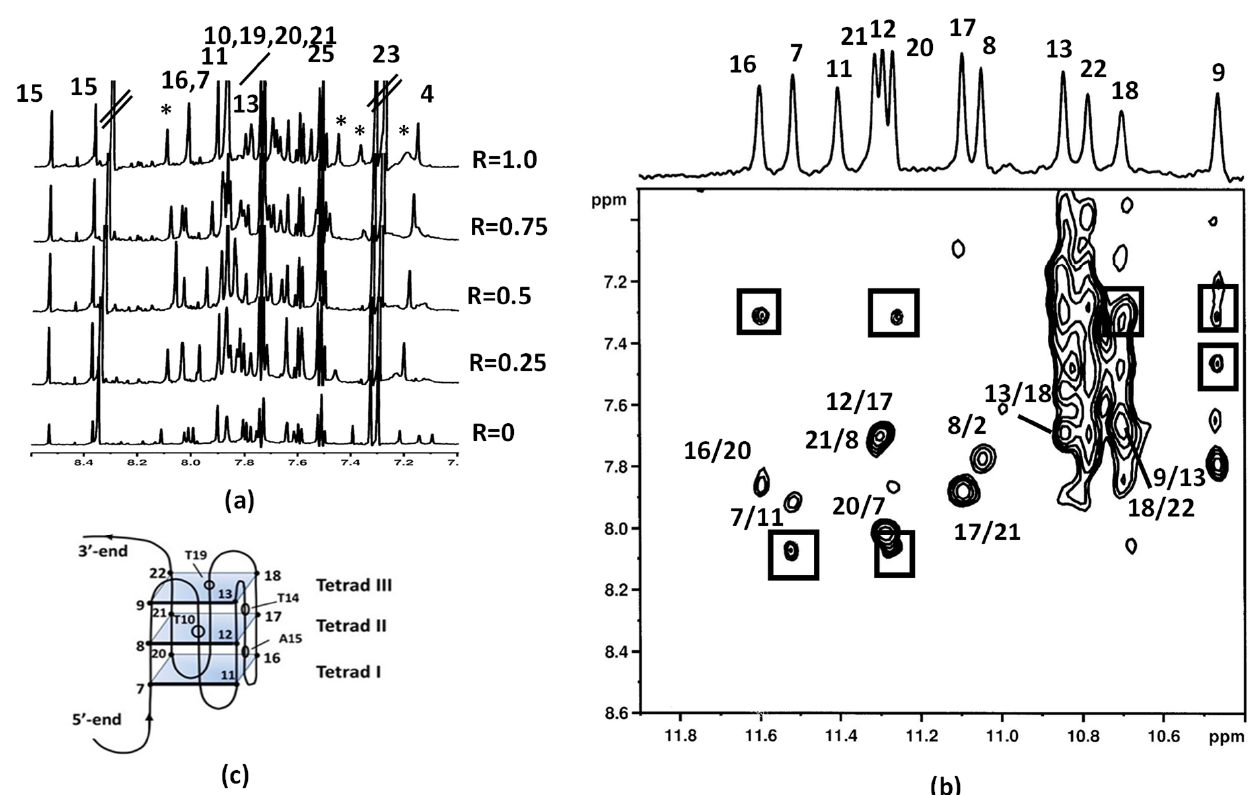
Figure 6. ( a ) Aromatic protons region of the 1 H NMR titration spectra of Pu22T14T23 with aloe emodin ‐ 8 ‐ glucoside. Aromatic protons of 2 are indicated by asterisk ( b ) 2D NOESY spectrum of Aloe emodin ‐ 8 ‐ glucoside at 25 °C in H 2 O/D 2 O (9:1), 70 mM KCl, 25 mM potassium phosphate buffer (pH 6.9), R = 1.0. The boxes indicate the intermolecular NOE interactions between imino protons of the G ‐ quadruplex and aromatic protons of the ligand. ( c ) Schematic representation of G ‐ quadruplex structure.